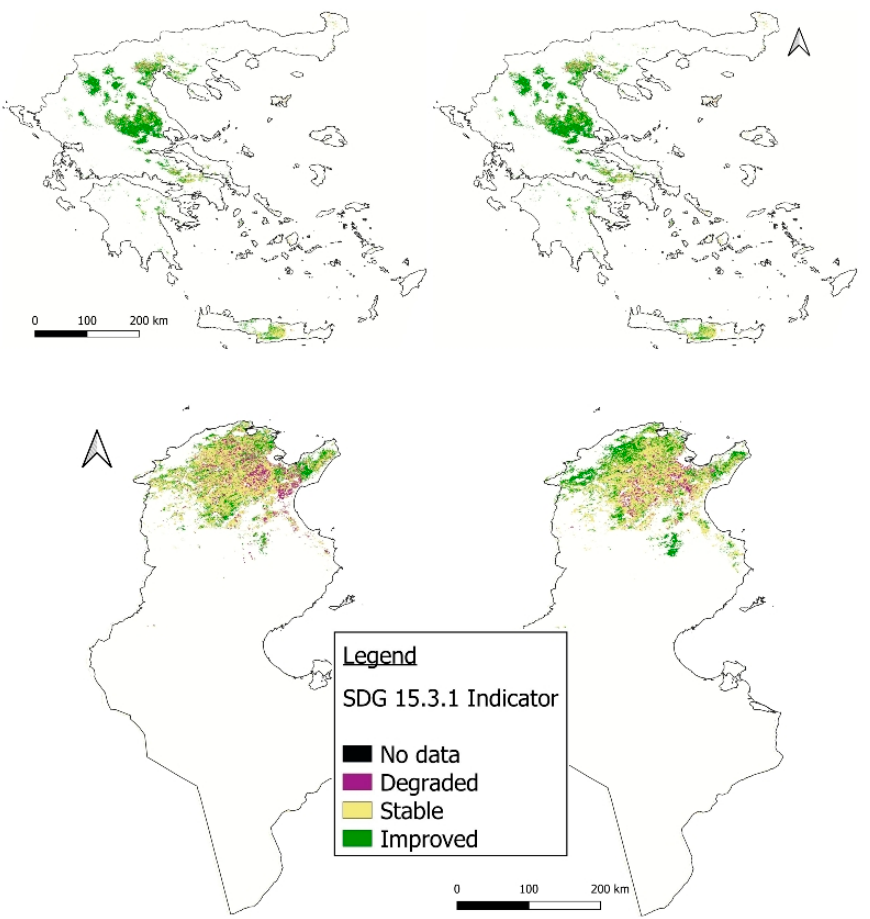
Figure 7. Spatial distribution of SDG 15.3.1 indicator in cereal croplands during the reporting period in Greece ( right ) and in Tunisia ( left ).